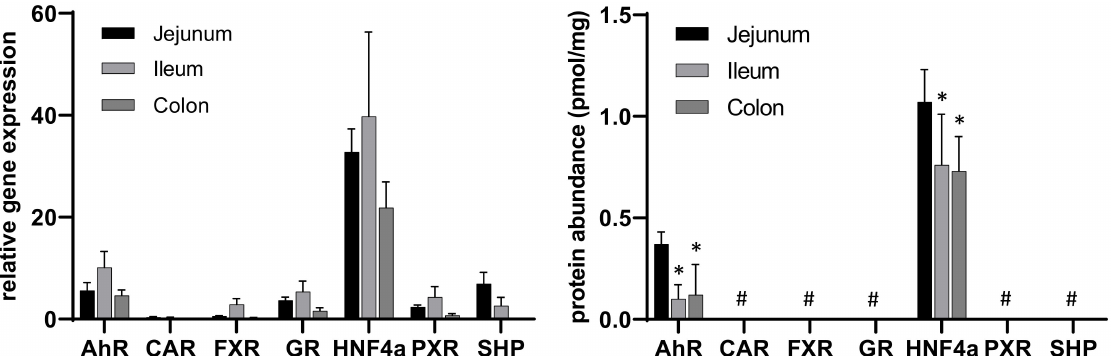
Figure 3. Data on gene expression ( left ) and protein abundance ( right ) of the investigated nuclear receptors along the human intestine (jejunum, ileum, colon) as measured, in each case, in N = 8 different donors (inter-subject comparison). Data given as mean ± SD. *: p ≤ 0.05 compared to jejunum, #: < lower limit of quantification.